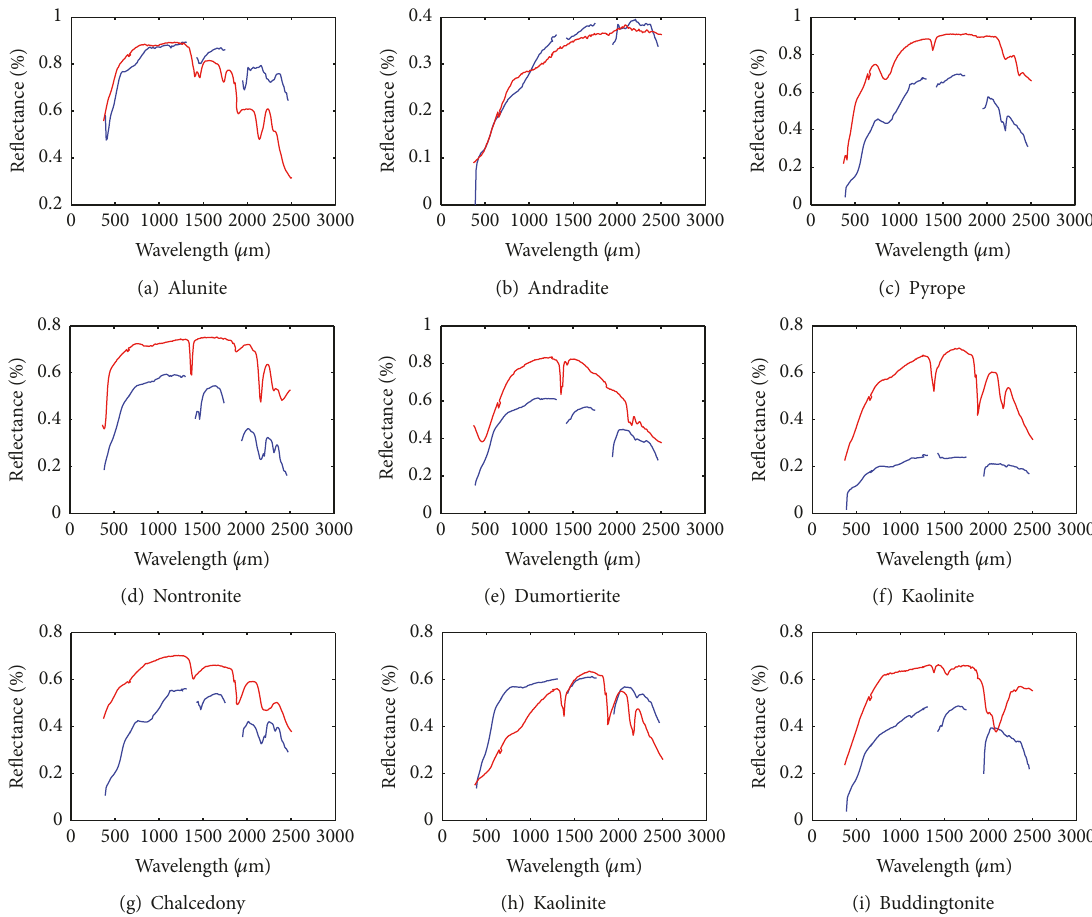
Figure 9: The comparison map between actual unmixing effect and endmember